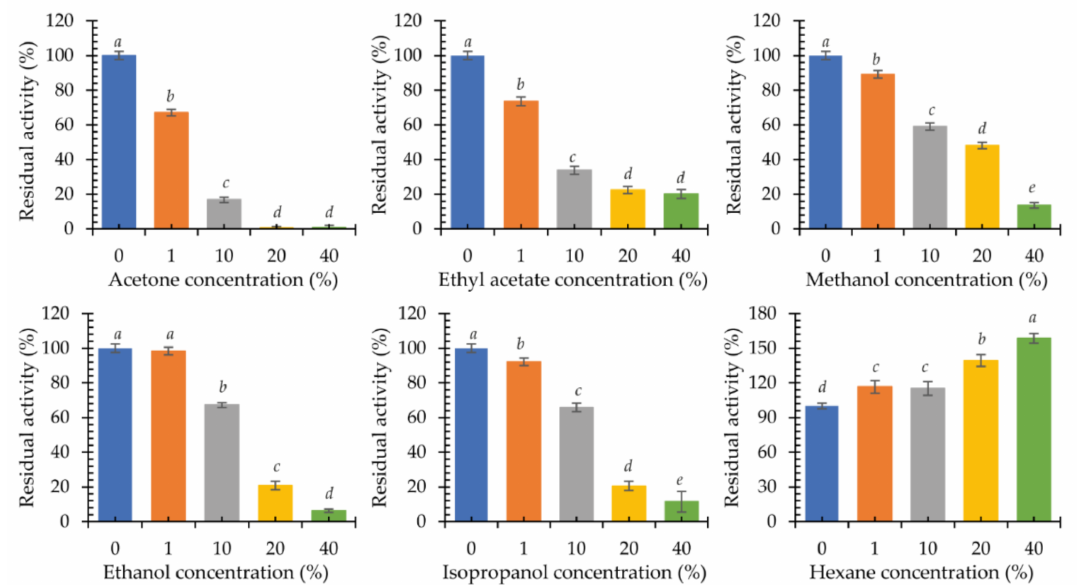
Figure 8. Activity of purified recombinant laccase KbLcc1 in the presence of organic solvents at 0%, 1%, 10%, 20%, 40% ( v / v ) concentration; the data presented as the means ± SD from at least three independent experiments; the means that are marked with different letters ( a – e ) are significantly different ( p < 0.05).